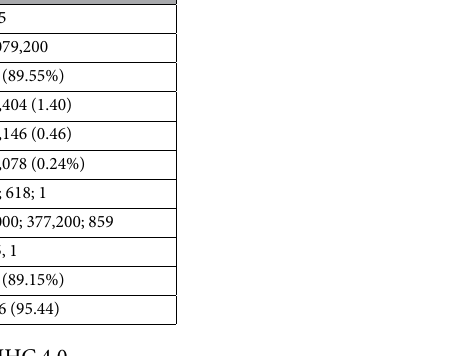
Table 1. Summary of predictions made with NetMHC